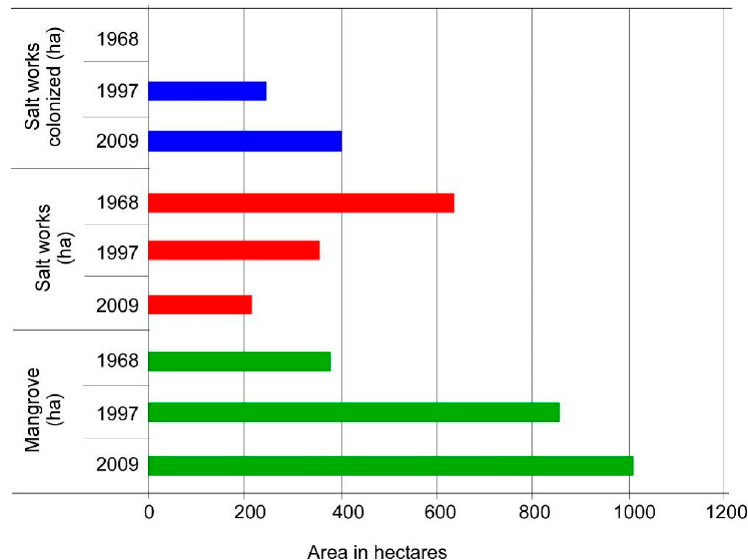
Figure 3. Evolution of the area in which the mangrove expanded, the saltworks decreased, and the mangrove forest colonized the abandoned saltworks (process of the regeneration of the mangrove between 1968 and 2009) in the Cear á estuary, in northeastern